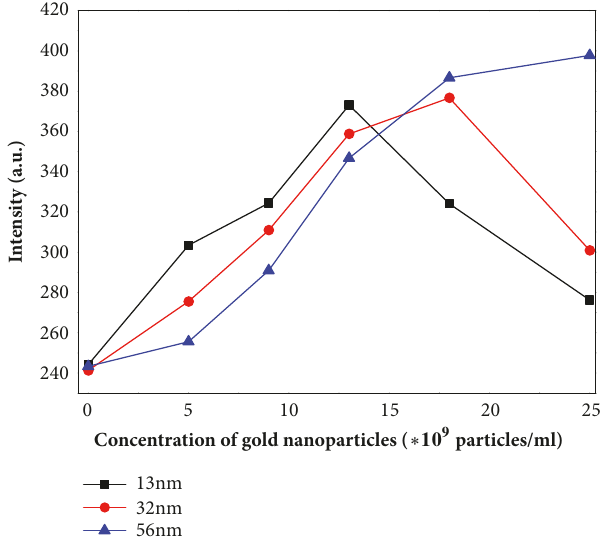
Figure 4: The peak intensity of PL emission versus concentrations of GNPs with diameter sizes of 13nm, 32nm, and